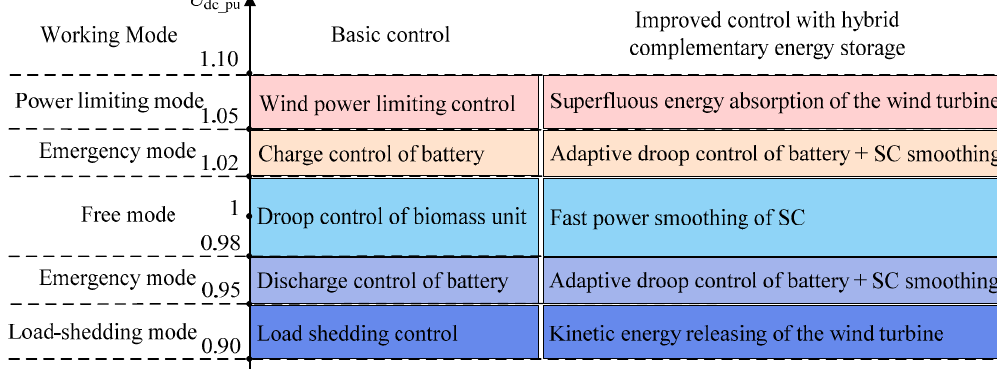
Figure 10. Comparison diagram of the basic control and the improved control of hybrid complementary energy storage.